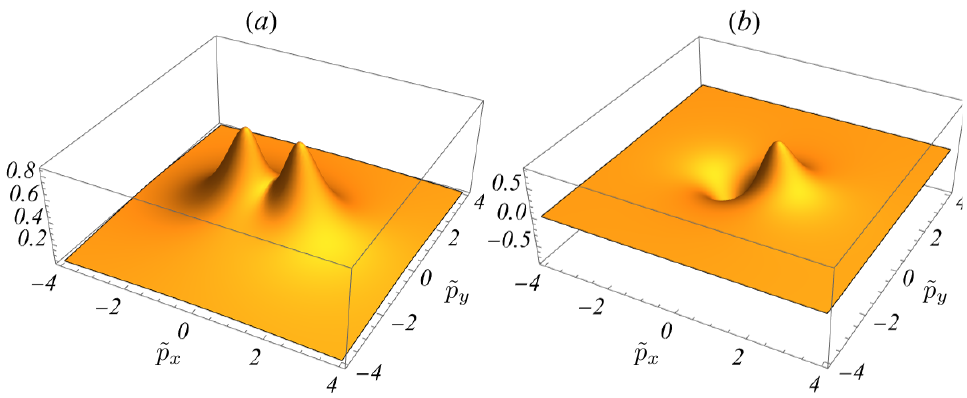
Figure 9: Orbital wave functions for two-fermion bound states formed in the pres- ence of 1D-type spin-orbit coupling ˆ λ ( p ) ≡ λ p